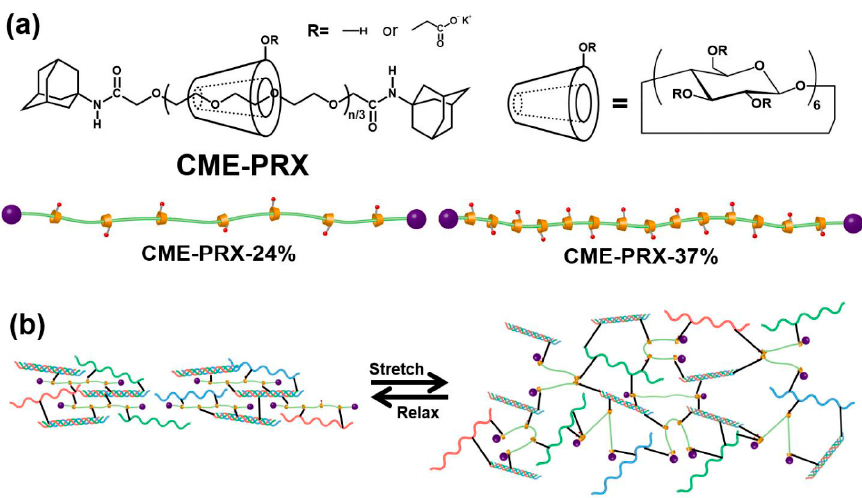
Figure 1. ( a ) Chemical structure of carboxymethyl ether group-modified polyrotaxanes (CME-PRXs); ( b ) Schematic illustration of gelatin hydrogels cross-linked with PRX under a stretch-and-relax environment.